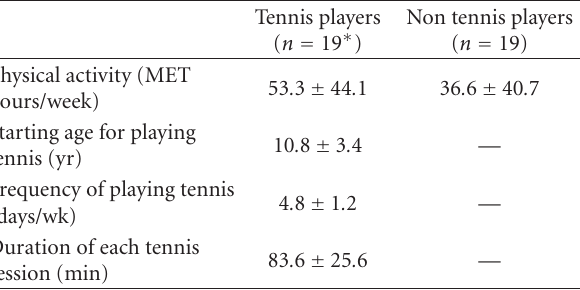
Table 4: Results of 7-Day Physical Activity (PA) Questionnaire and tennis playing